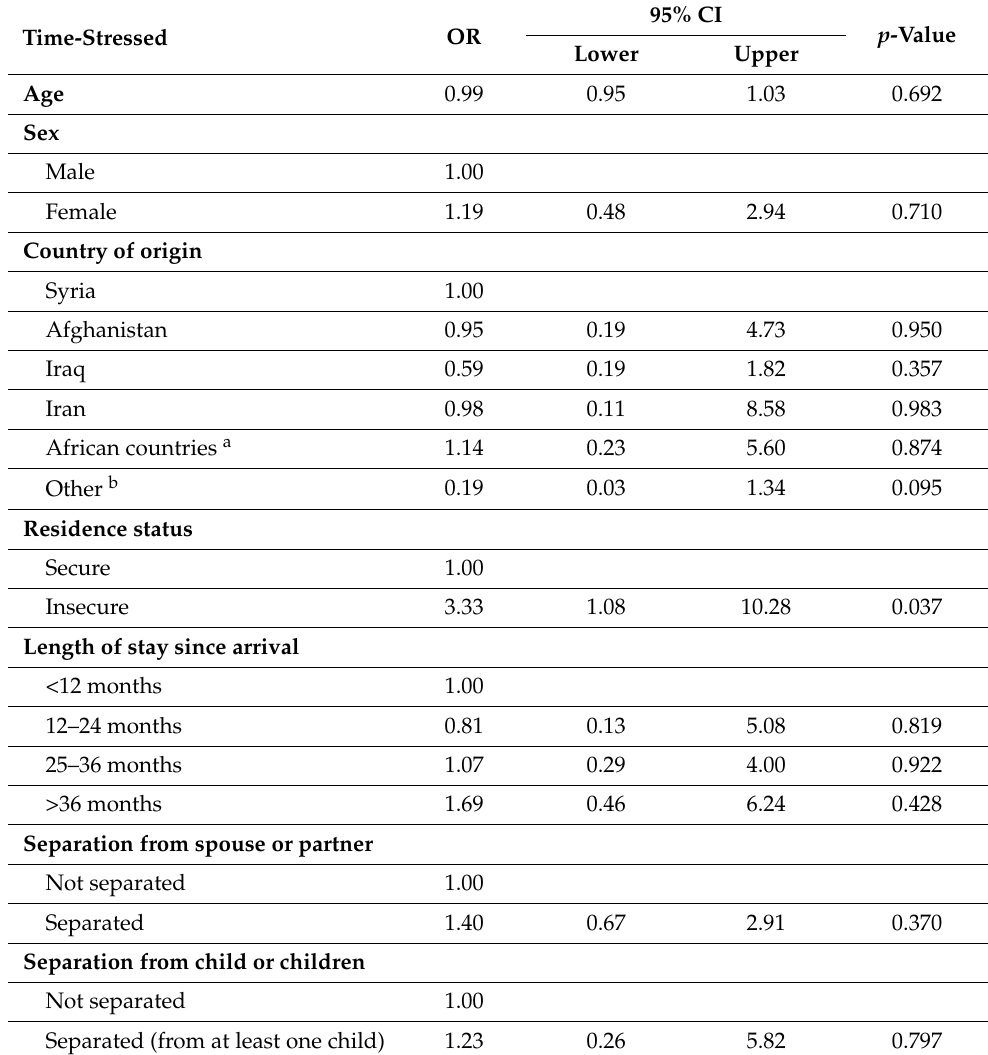
Table 3. Results of logistic regression analysis on predictors for being time-stressed ( n = 129). Time-Stressed OR